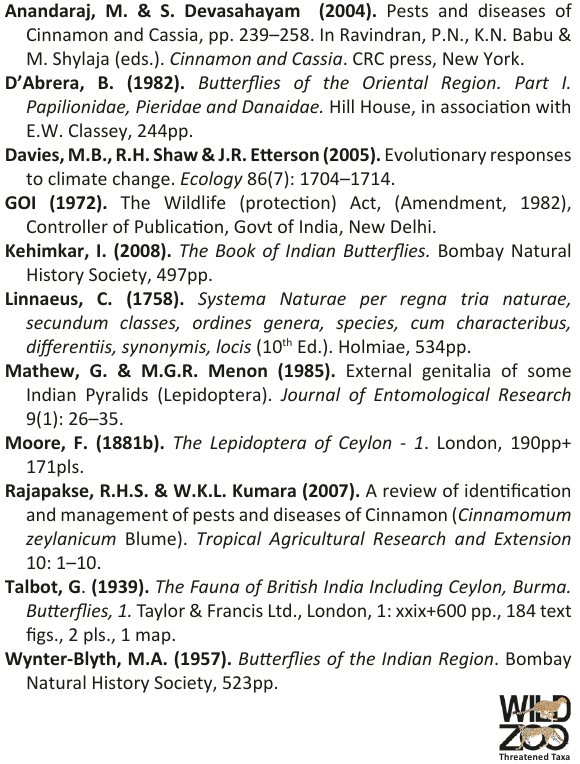
figs., 2 pls., 1 map. Wynter-Blyth, M.A. (1957). Butterflies of the Indian Region . Bombay Natural History Society, 523pp.